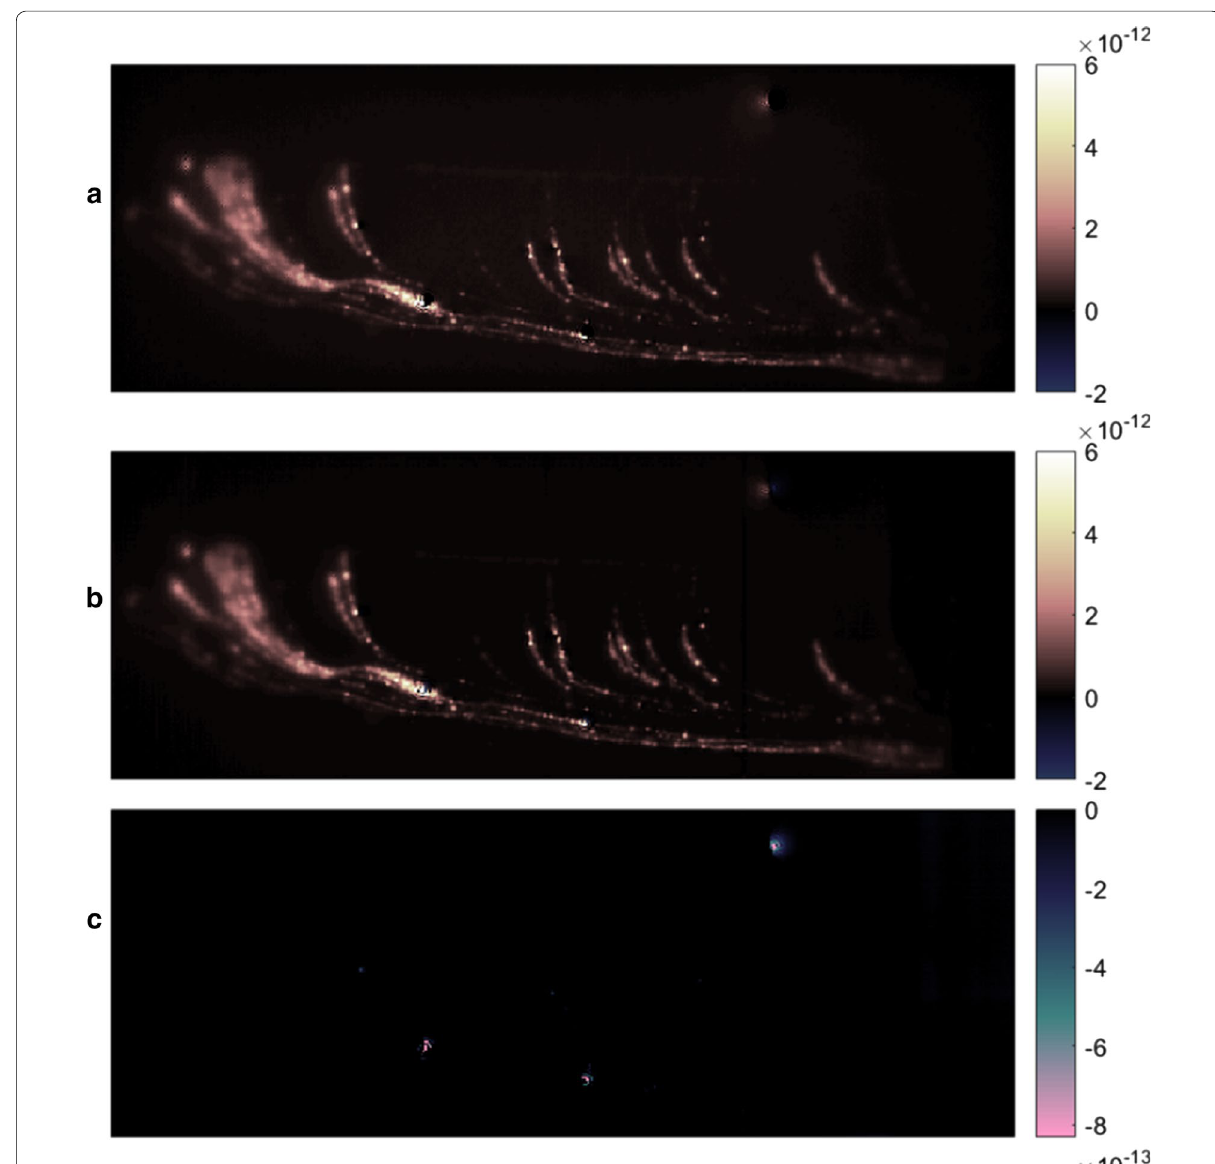
Fig. 14 A comparison of spatial and frequency domain inversion results for the SVC982 speleothem showing a the SIRM magnetic moments found using the TNT-NN unidirectional inversion (dipoles oriented out of page) with 100 µ m dipole spacing, b the SIRM magnetic moments found using the Fourier technique of Lima et al. (2013) with 100 µ m dipole spacing (dipoles oriented out of page), and C the Fourier solution where only non-negativity constraint violations (undershoot) are shown (bottom). The field of view for all images is 50.1 mm × 18.1 mm. All units are Am